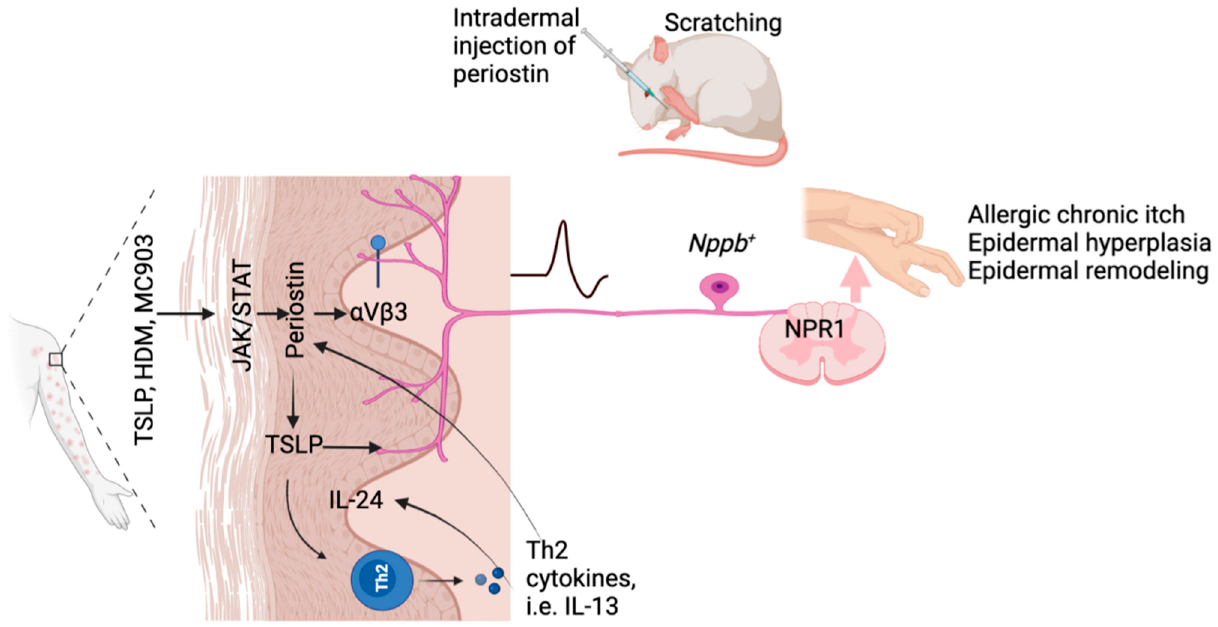
Figure 3. TSLP–periostin–TSLP–NPPB loop in peripheral itch. Periostin is abundantly expressed in the skin of AD patients. TSLP, HDM, and MC903 induce periostin release in a